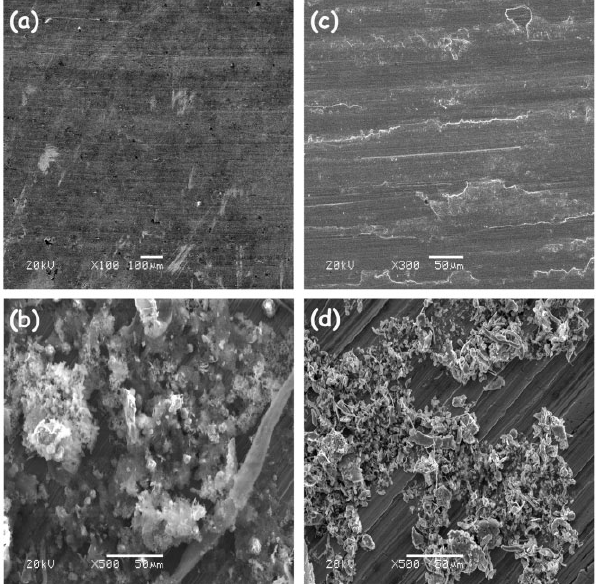
Fig. 9 SEM morphology of worn surface and wear debris for